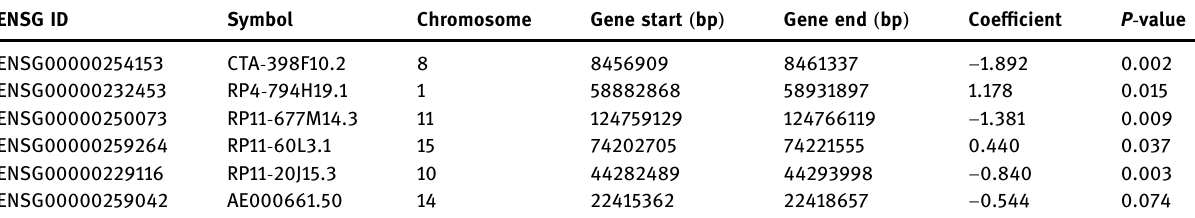
Table 2: Information of the lncRNAs in the autophagy - related lncRNAs risk model for predicting PFI of patients with papillary thyroid carcinoma ENSG